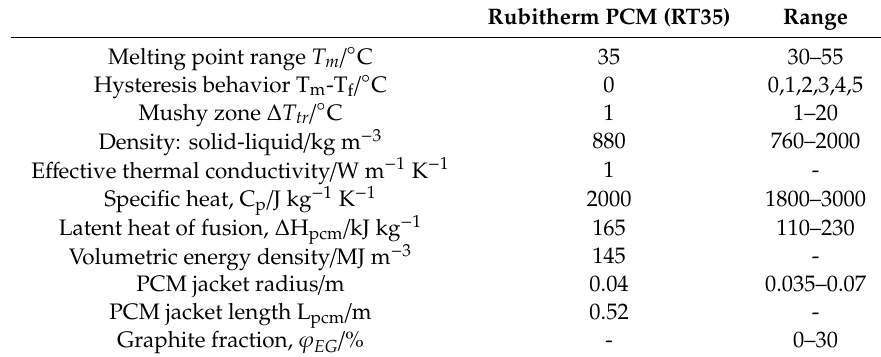
Table 2. The baseline thermophysical parameters of para ffi n-based PCM extracted from [33,34,41].